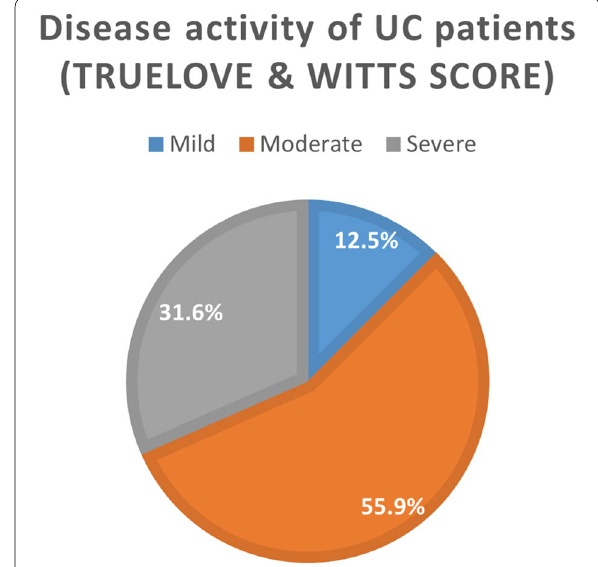
Fig. 4 Degree of severity of ulcerative colitis (Truelove & Witts score) at index presentation